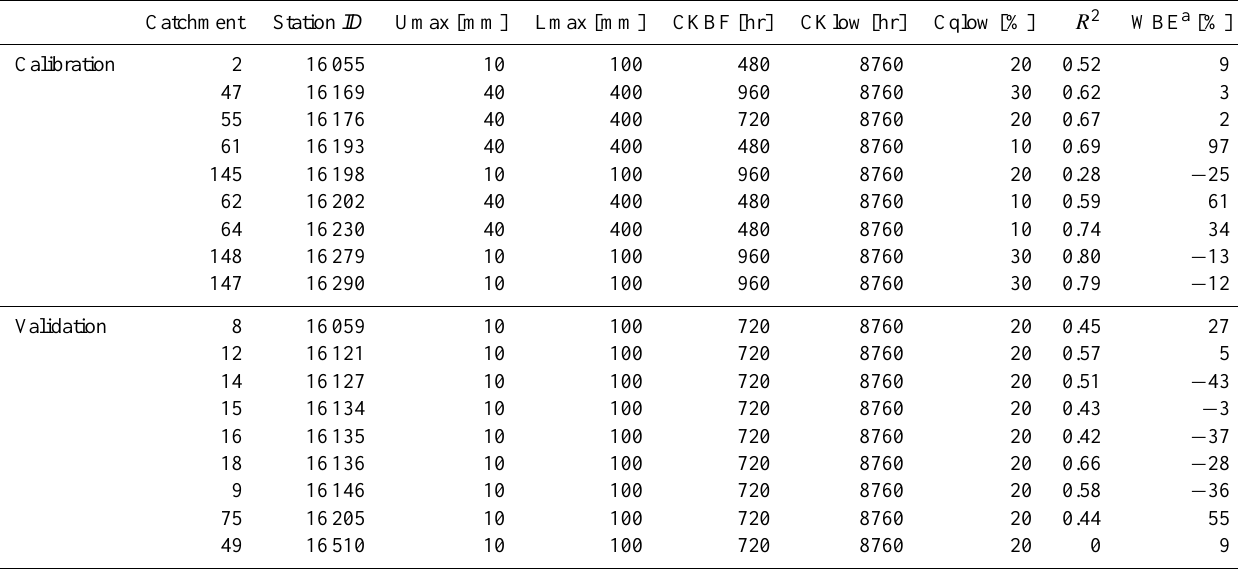
Table 5. Results of the rainfall-runoff model calibration. The column R 2 contains the coefficient of determination of the rainfall-runoff model for each subcatchment.